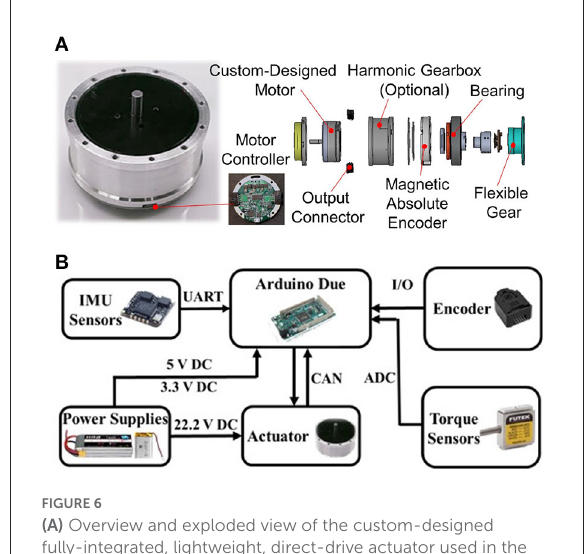
FIGURE6 (A) Overview and exploded view of the custom-designed fully-integrated, lightweight, direct-drive actuator used in the design of the knee exoskeleton (B)